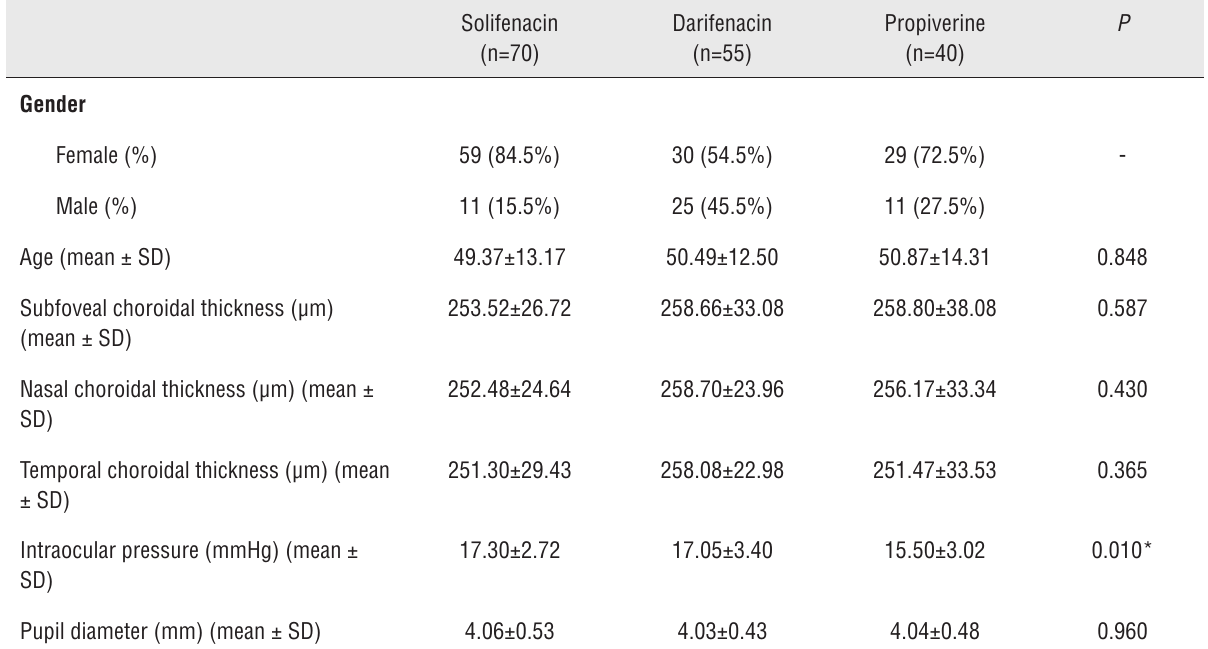
Table 1 - The pretreatment results of descriptive analysis regarding to three anticholinergic groups are